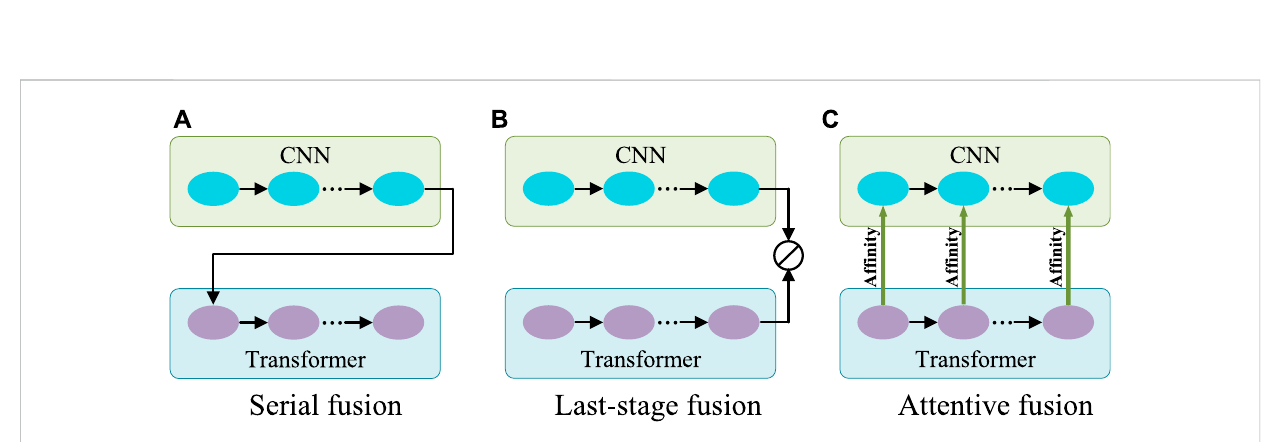
FIGURE 3 Threedifferentfusionschemes. (A) Serialfusion; (B) Last-stageFusion; (C) Attentivefusion.Note:1)CNNandTransformercanchangetheirordersin the serial fusion; 2) ⊘ in (B) represents the fusion